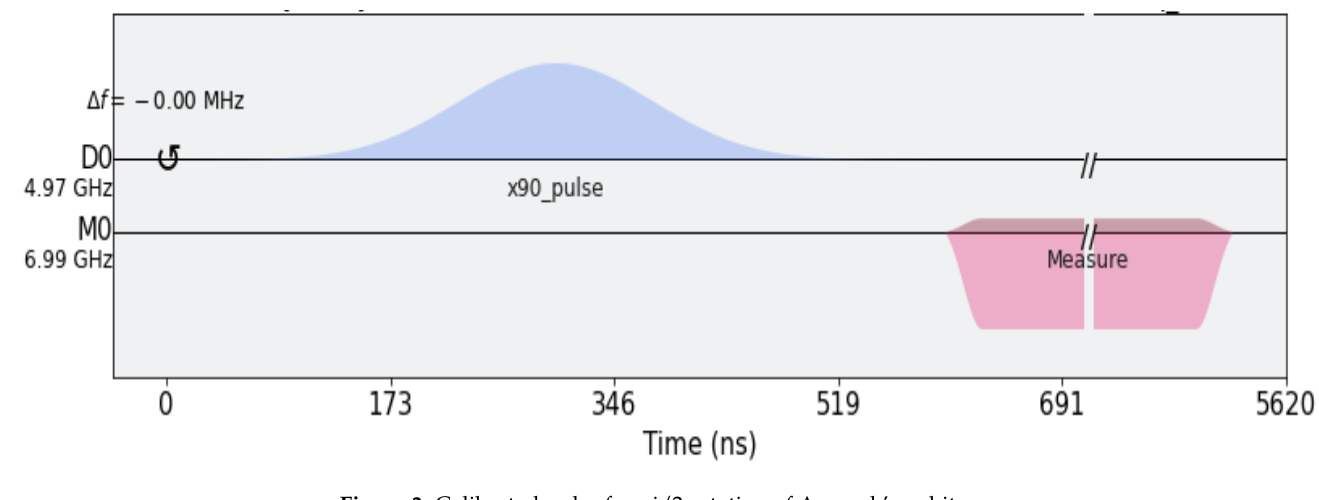
Figure 3. Calibrated pulse for pi/2 rotation of Armonk’s qubit. Figure 3. Cali brated pulse for pi/2 rotation of Armonk’s qubit . Figure 3. Cali brated pulse for pi/2 rotation of Armonk’s qubit .